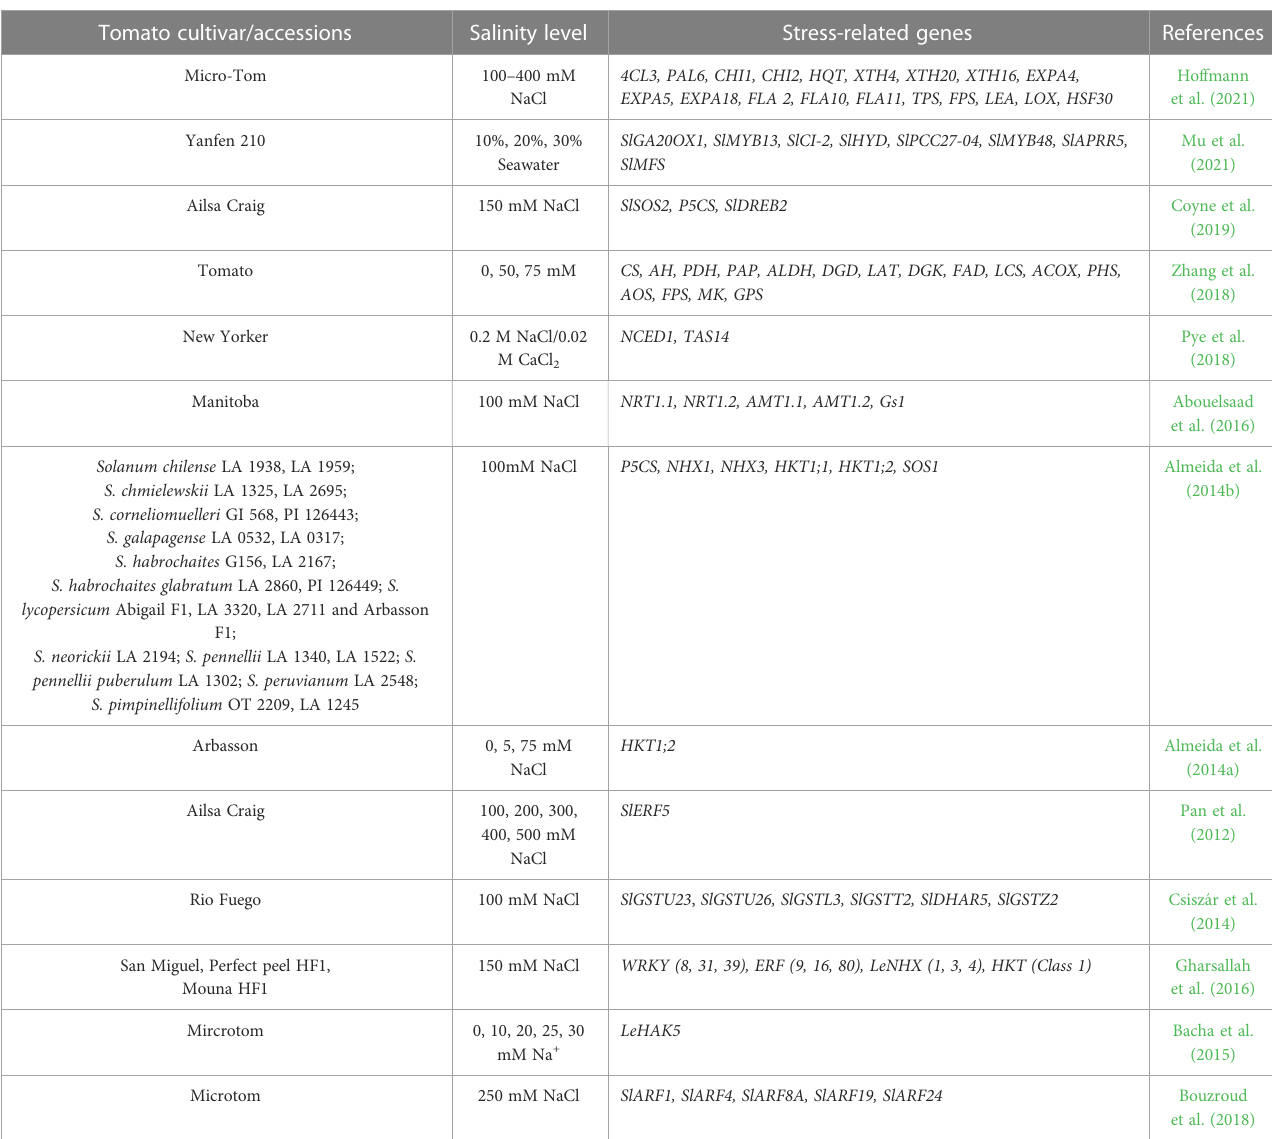
TABLE 5 Salinity stress-related genes in tomato plants. Tomato